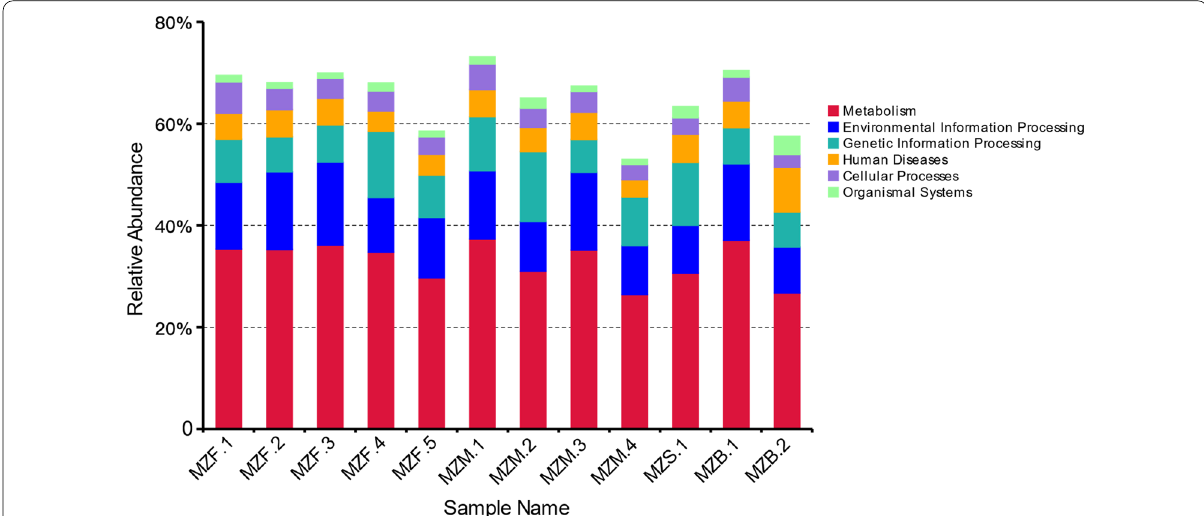
Fig. 4 Relative abundance of pathways